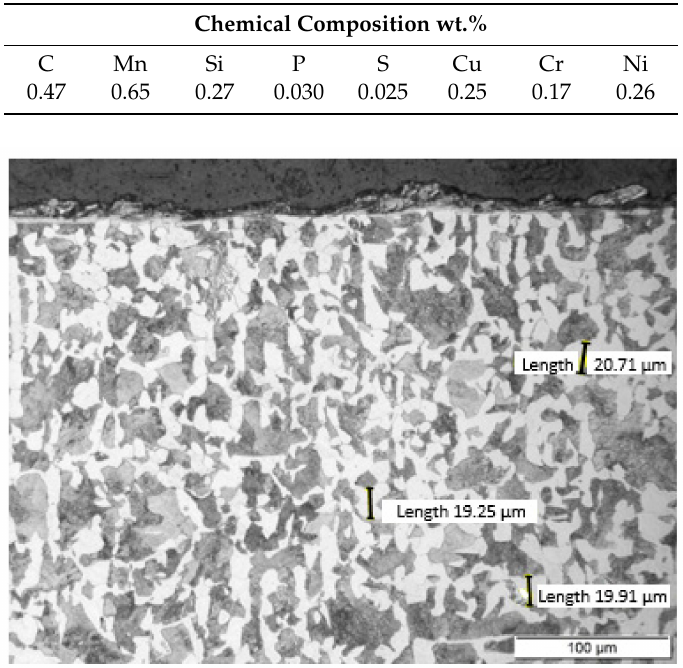
Figure 2. The ferritic-pearlitic microstructure of C45 steel after annealing. Sample etched with Nital. Photograph was taken using a light microscope LM